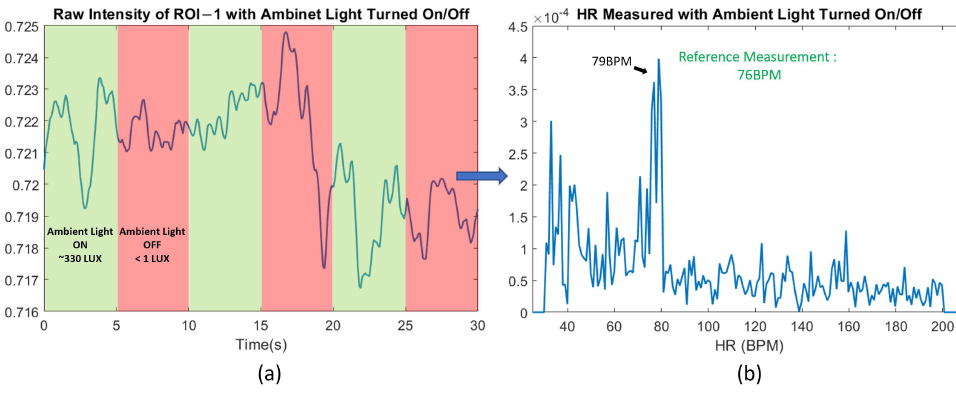
Figure 4. ( a ) Raw intensity signal from ROI-1 measured under alternating dark and bright environ- ment. The ambient is swithced on/off at an interval of 5 s. ( b ) Frequency domain HR measured under alternating lighting condition. The highest peak in the frequency domain correspond to measured HR.